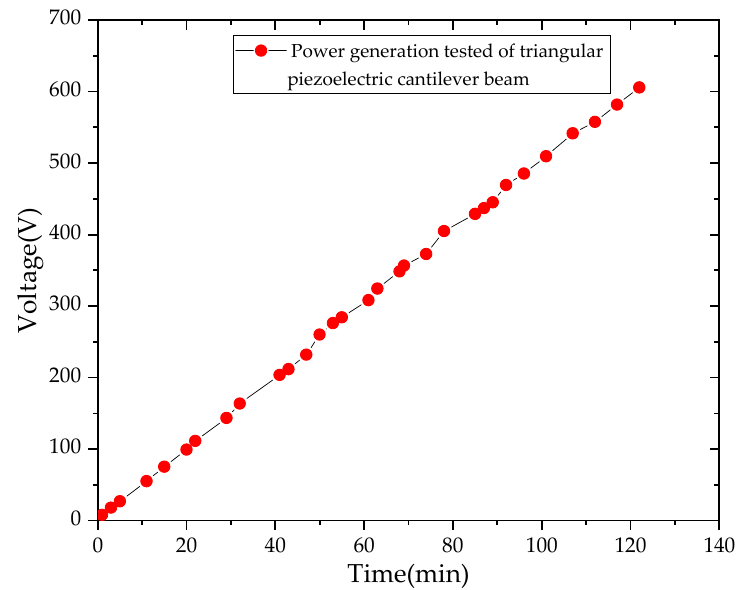
Figure 25. The relationship between power generated by triangular PCB with time.